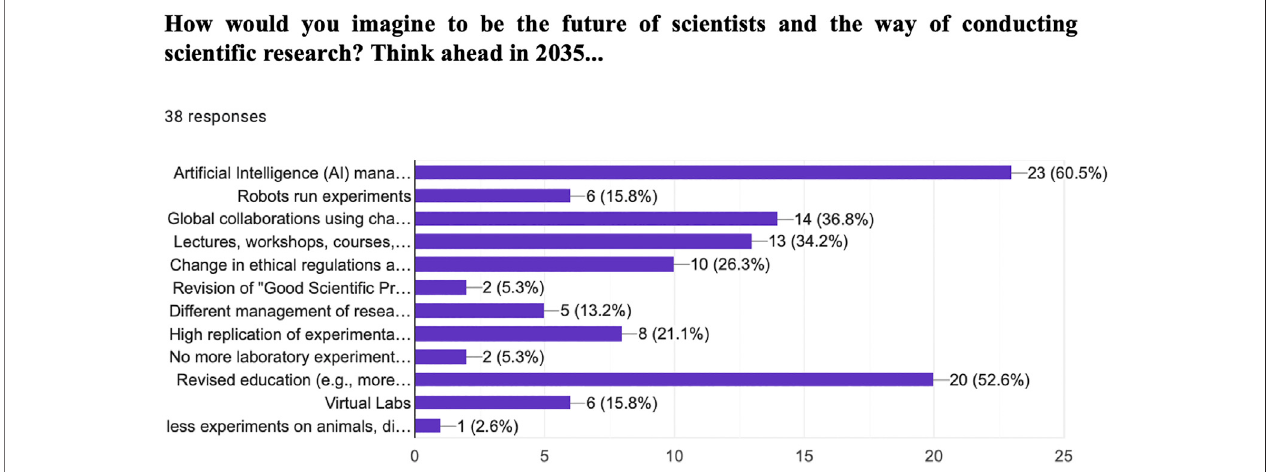
FIGURE 1 | Bar chart. How would you imagine to be the future of scientists and the way of conducting scienti fi c research? Think ahead in 2035... Options were: Arti fi cialIntelligence(AI)managesbigdatasets(i.e.,severaldataanalysisdoneinparallel),robotsrunexperiments,globalcollaborationsusingchannel-basedmessaging/ meeting platforms, lectures, workshops, courses, and meetings happening entirely online, change in ethical regulations and regulatory approvals, revision of “ Good Scienti fi c Practice ” procedures, different management of research funds/different research costs, high replication of experimental procedures among Labs (e.g., usingAI,robots),nomorelaboratoryexperimentsonhumans/animals(i.e.,ideally,precisesimulationswithAI),revisededucation(e.g.,moredigitalandtechnologyskills, interdisciplinary education), virtual Labs, other. The most common answers were “ Arti fi cial Intelligence (AI) manages big datasets (i.e., several data analysis done in parallel) ” (60.5%), “ Globalcollaborationsusingchannel-basedmessaging/meetingplatforms ” (36.8%)and “ Revisededucation(e.g.,moredigitalandtechnologicalskills, interdisciplinary education) ”